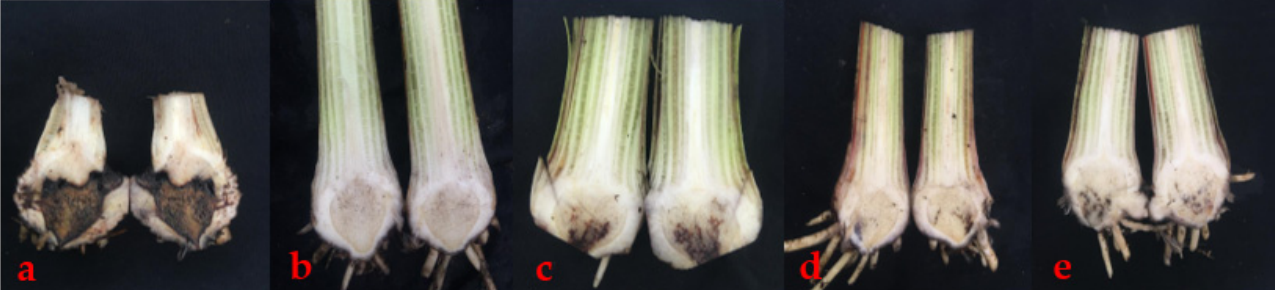
Figure 6. Effect of fungal phylloplane from mangrove on the degree of rhizome discoloration caused by Fusarium wilt ( a ) K + (Without fungal phylloplane), ( b ) K − (untreated), ( c ) Trichoderma harzianum , ( d ) Nigrospora sphaerica ( e ) Lasiodiplodia theobromae.